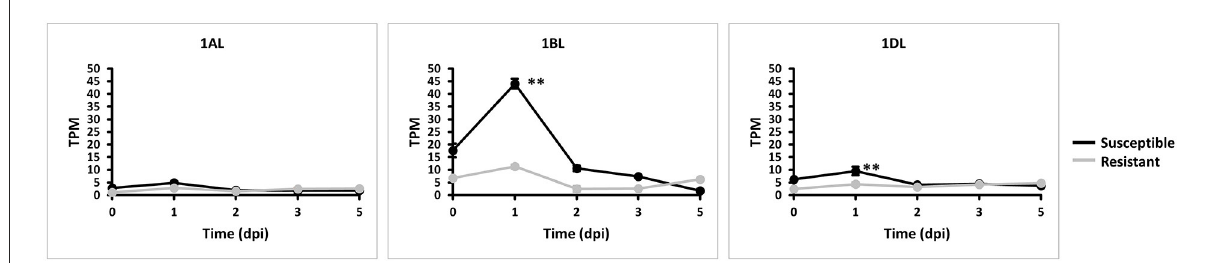
FIGURE3 Expression of TaMYC4 (1AL, 1BL and 1DL) homeologs during stripe rust–Avocet Yr5 (resistant) and Vuka (susceptible) interactions. TPM is transcript per million. Error bars represent standard deviation among three biological reps and ** denote statistical significance at the P ≤ 0.01 levels calculated between each time point and 0 dpi.